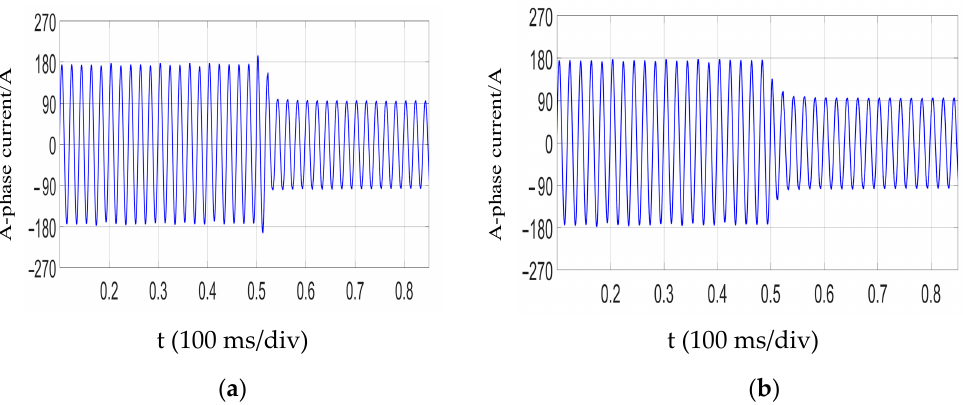
Figure 13. A-phase current waveform when the load suddenly increases: ( a ) Controlled by backstepping control method; ( b ) Controlled by SMVS.